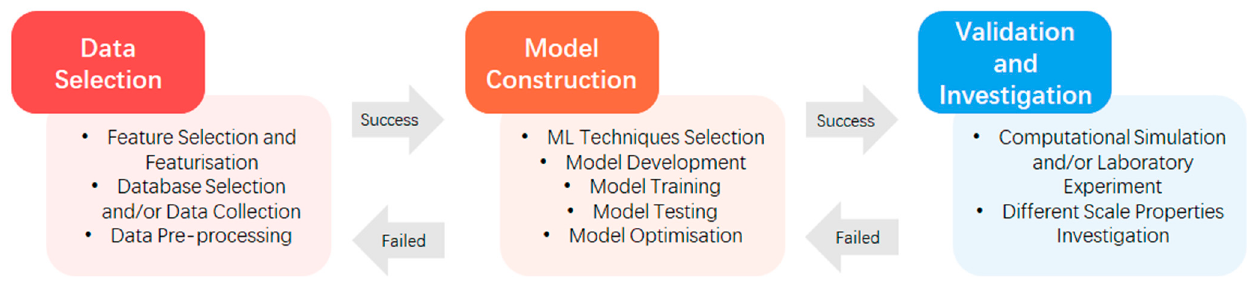
Figure 2. Simpli fi ed framework for SSE materials discovery using ML data-driven approaches. Figure 2. Simplified framework for SSE materials discovery using ML data-driven